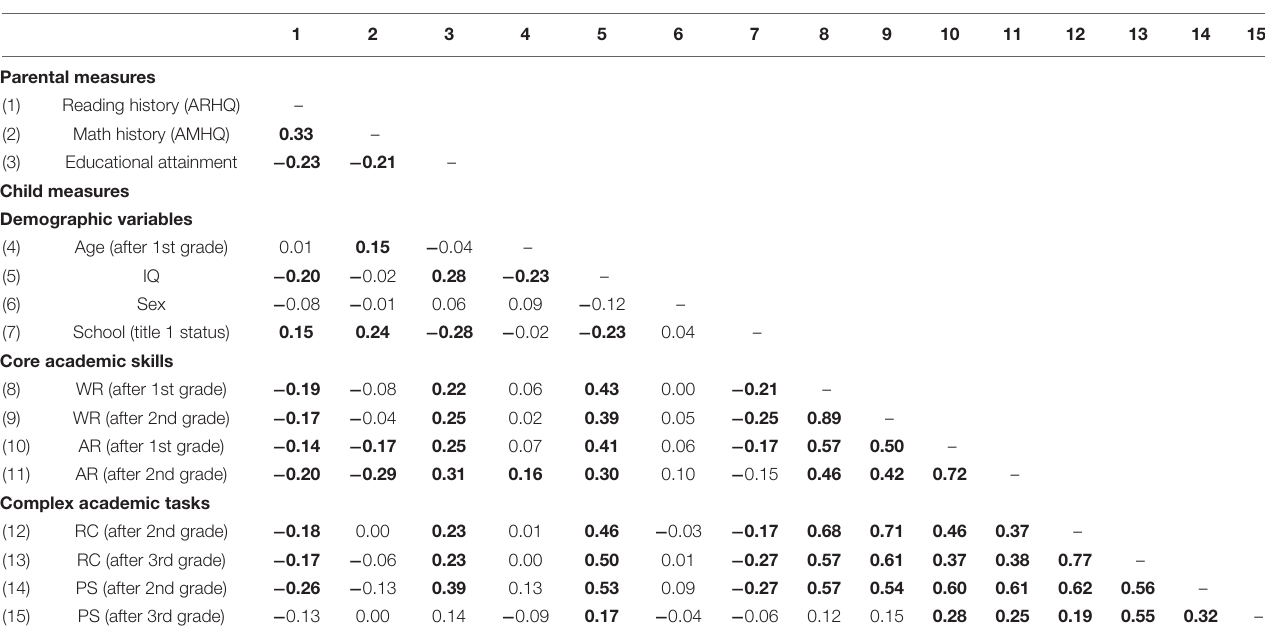
TABLE 5 | Pairwise correlations among parental measures [reading history (ARHQ), math history (AMHQ), and educational attainment] and children’s demographic variables [age, IQ (at baseline), sex, and school information (Title 1 Status)], core academic skills [word recognition (WR) and arithmetic calculation (AR)], and performance on complex tasks [reading comprehension (RC) and problem solving